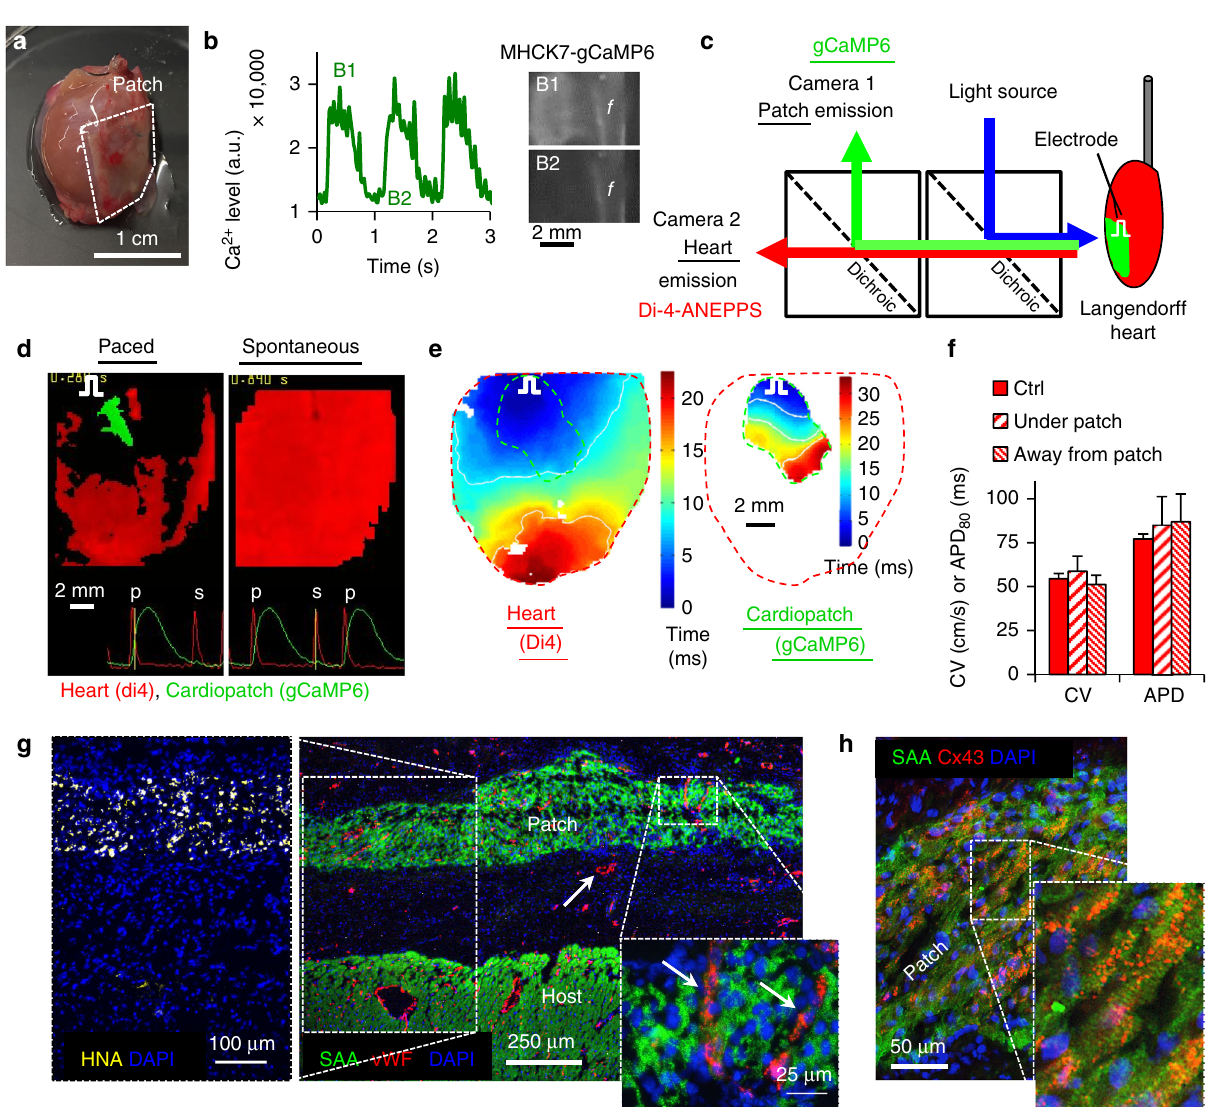
Fig. 7 Epicardial implantation and ex vivo assessment of cardiopatches. a Representative image of cardiopatch 3 weeks following implantation onto nude rat epicardium; f, cardiopatch frame. b MHCK7-gCaMP6 fl ashes in implanted cardiopatches following direct stimulation by a platinum electrode; f, cardiopatch frame. c Schematic of a setup for dual optical mapping of gCaMP6-reported Ca 2+ transients in implanted cardiopatches and Di-4-ANEPPS- reported transmembrane voltage in Langendorff-perfused rat hearts. d Representative snapshots from movies of Ca 2+ transients in cardiopatches (green) and membrane voltage in the heart (red). Traces at the bottom show representative gCaMP6 (green) and Di-4 (red) signals from a single recording channel with yellow line denoting point in time corresponding to the instant of the movie snapshot. Pulse sign denotes location of stimulus electrode; p, paced; s, spontaneous. e Representative isochronal maps of action potential propagation during direct point electrode stimulation (pulse sign) of implanted cardiopatch (black dashed outline) and underlying rat myocardium (red dashed outline). f CV and APD of host epicardium optically recorded in control conditions (no patch), under implanted cardiopatch (under patch), and remote from implanted cardiopatch (away from patch); n = 6/3/3 (control/under/away). g , h Representative cross-sections of cardiopatch 3 weeks after implantation onto rat epicardium stained for SAA, von Willebrand Factor (vWF), and human nuclear antigen (HNA, h ) and SAA and Cx43 ( h ). Data are presented as mean ± SEM. Scale bars a 1 cm; B1 – 2 2 mm; d , e 2 mm; g main: 250 µ m, left inset: 100 µ m, right inset: 25 µ m; h 50 µ